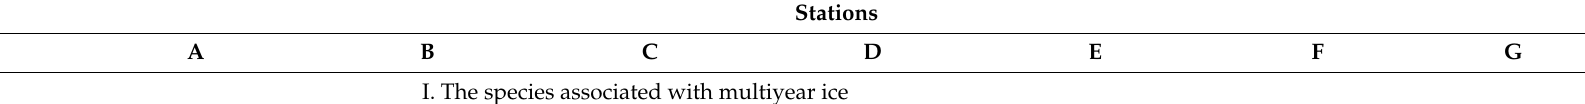
Table 5. Vertical location (m) of species of the main phytoplankton complexes in the Nansen Basin and the northern shelf of the Barents